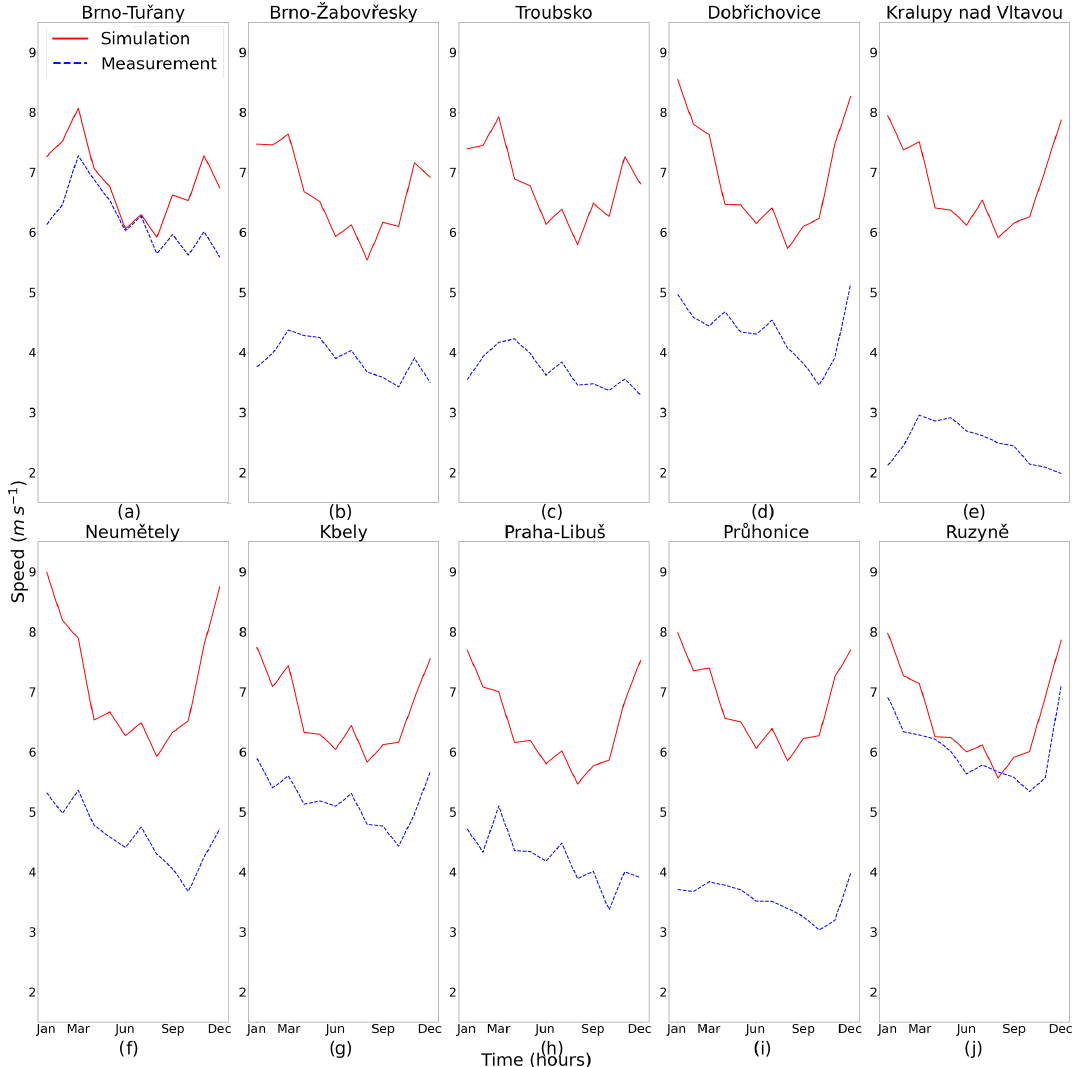
Figure 8. Comparison of the modelled annual cycle of the monthly mean of maximum daily wind speeds (solid red lines) with measurements (dashed blue lines) from 10 Czech stations averaged over the 2007–2016 period. Units are metres per